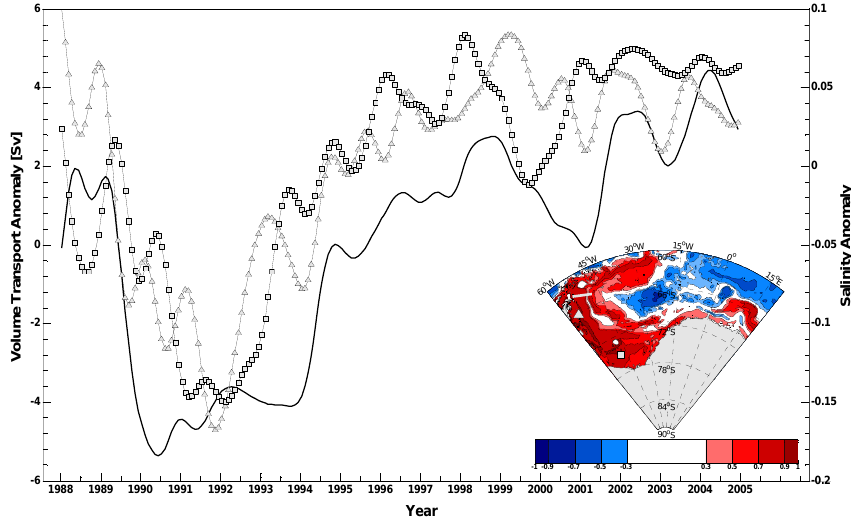
Fig. 17. Bottom-layer volume transport anomaly time series (Sv; black line) of Weddell cross-slope section 1 (inset figure – grey line) and salinity anomaly time series at the locations marked by square and triangle symbols in the inset figure (see caption of Fig. 18), which shows the high degree of correlation between the time